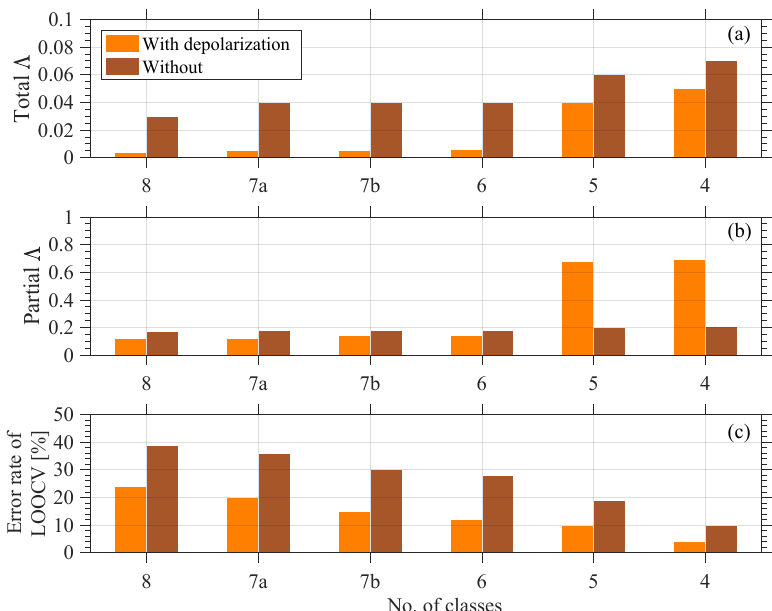
Figure 6. Bar plots showing (a) the total (cid:51) , (b) the partial (cid:51) , and (c) error rate of LOOCV when comparing the training of the algorithm with (i.e., S 532 aer /S 355 aer , S 532 aer , and κ β ( 355 , 1064 ) ) and without (i.e., δ 532 aer , S 532 aer , and κ β ( 355 , 1064 ) ) particle linear depolarization values. For the partial (cid:51) , the brown bars correspond to the backscatter-related Ångström exponent and orange one to the particle linear depolarization ratio because they represent the most significant classifying parameter of the